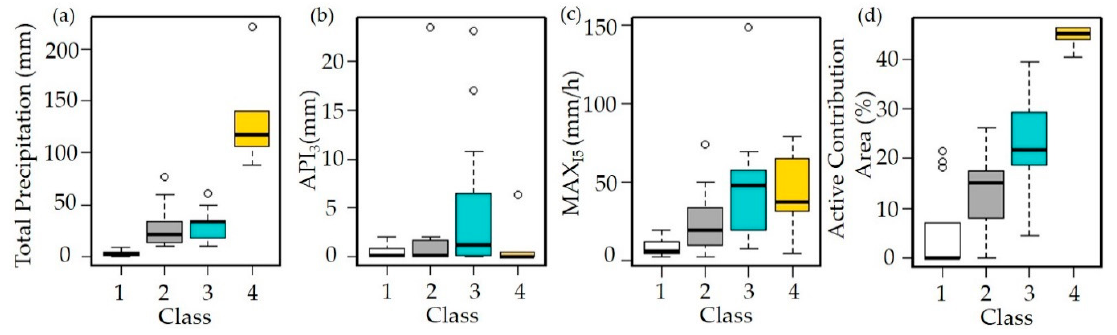
Figure 5. Boxplot of predictor variables for the four event classes. ( a ) Total precipitation, ( b ) antecedent precipitation index (API 3) . ( c ) Maximum 5minute precipitation intensity (MAX I5) . ( d ) Active contribution area. Open circles are outlier values.